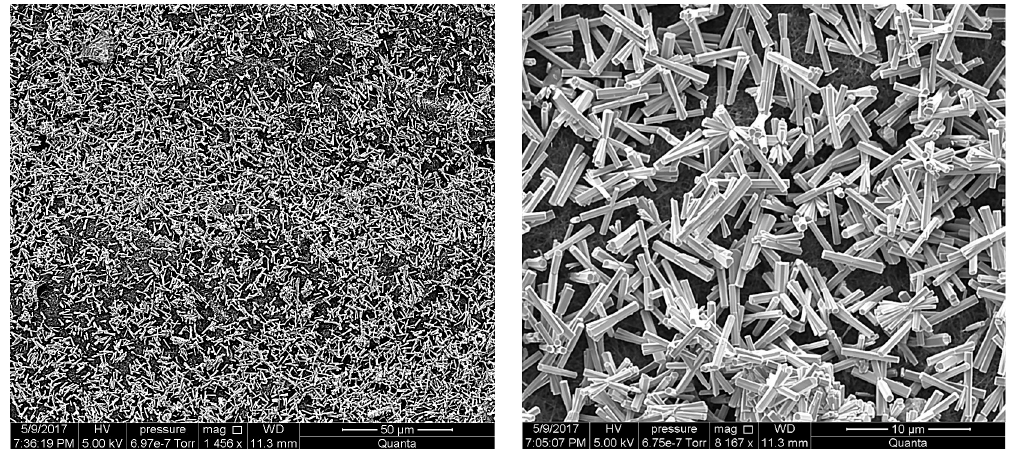
Figure 2. ZnO nanorods grown on Bucky paper substrate at different magnifications.